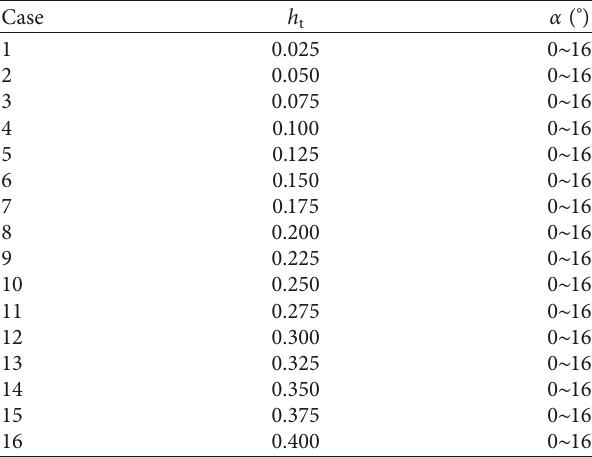
Table 2: Parameters in the model.